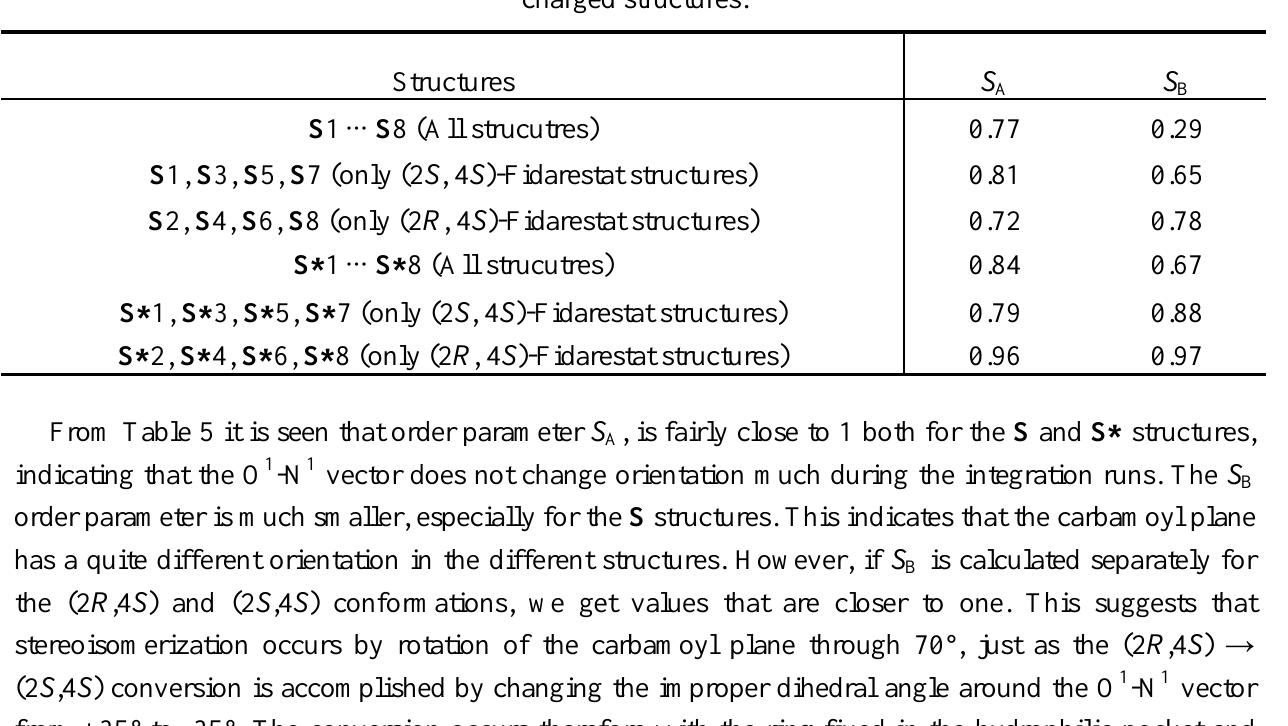
Figure 7. A schematic representation of the vectors and the order parameters to define the orientation of the inhibitor at the active site. S Table 5. The order parameters S